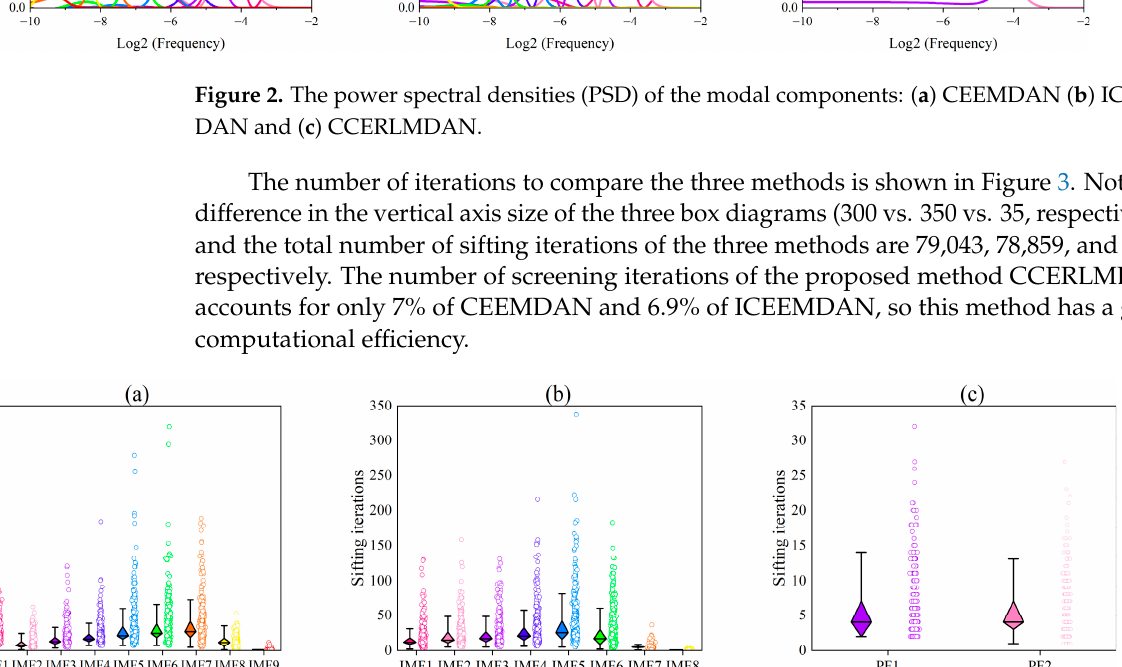
Figure 2. The power spectral densities (PSD) of the modal components: ( a ) CEEMDAN ( b ) ICEEMDAN and ( c ) CCERLMDAN.